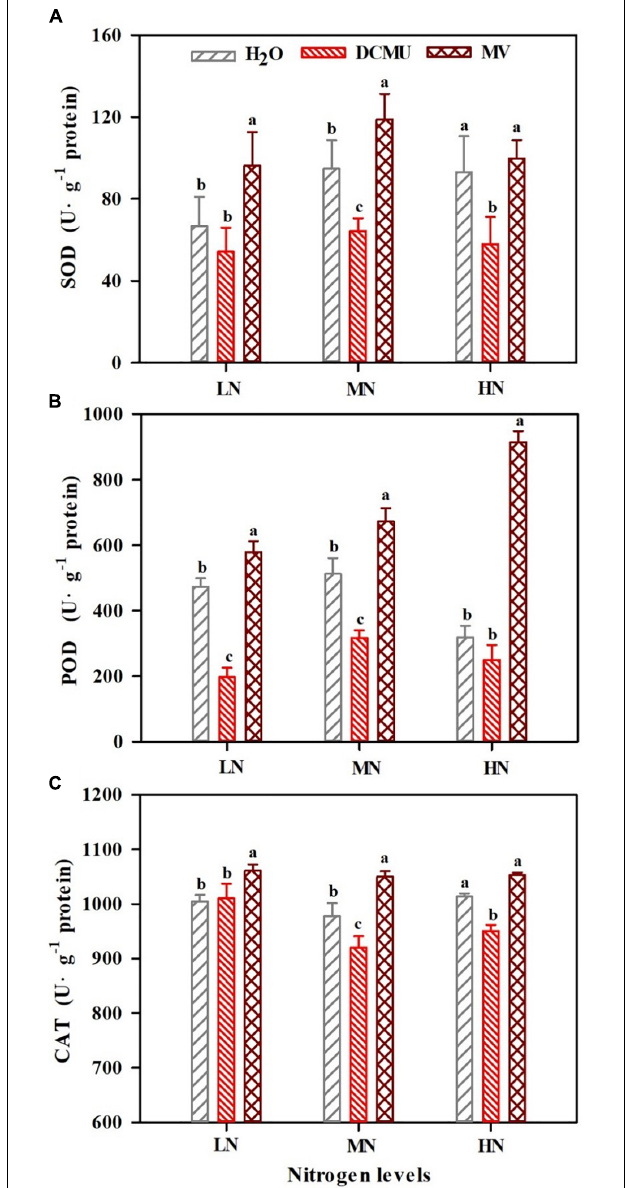
FIGURE 9 | Effects of 3-(3,4-dichlorophenyl)-1,1-dimethyl urea (DCMU) and methyl viologen (MV) on superoxide dismutase (SOD) (A) , peroxidase (POD) (B) , and catalase (CAT) (C) in leaves of Panax notoginseng grown under different nitrogen regimes. Values for each point were mean ± SD ( n = 5). Letters indicate significant differences at p ≤ 0.05 according to Duncan’s multiple range